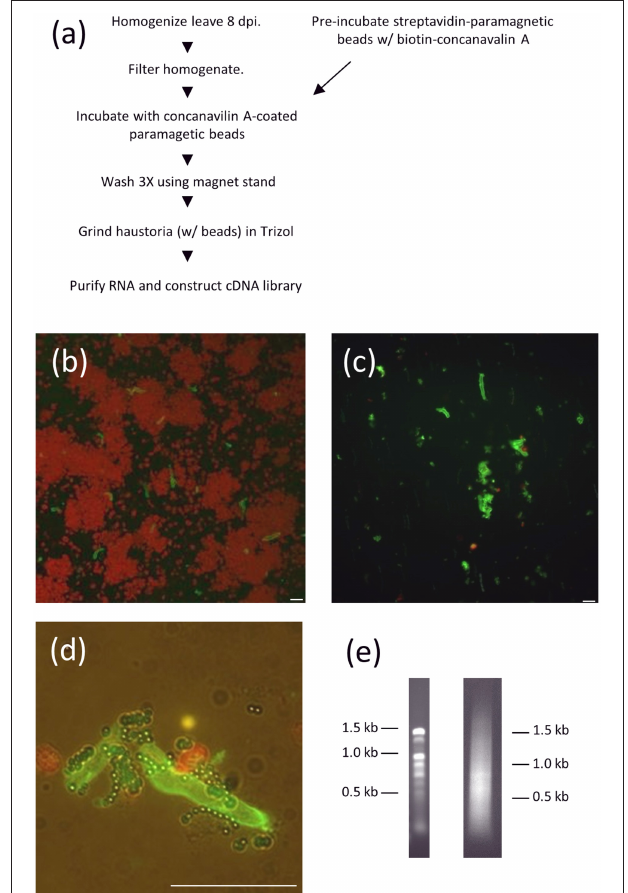
FIGURE 1 | RNA purification from isolated P. pachyrhizi haustoria. (A) Schematic of haustorial RNA purification. (B) Micrograph of ConA-FITC-stained haustoria after homogenization and filtration through Nytex membrane. Red objects are chloroplasts. Bar = 10 µ m (C) ConA-FITC stained haustoria after paramagnetic bead purification. Bar = 10 µ m (D) Close up of ConA-FITC stained haustoria after purification showing association with paramagnetic beads. Bar = 10 µ m (E) 1% Agarose gel separation of 1 µ g haustorial RNA (left) and 0.5 µ g cDNA prep